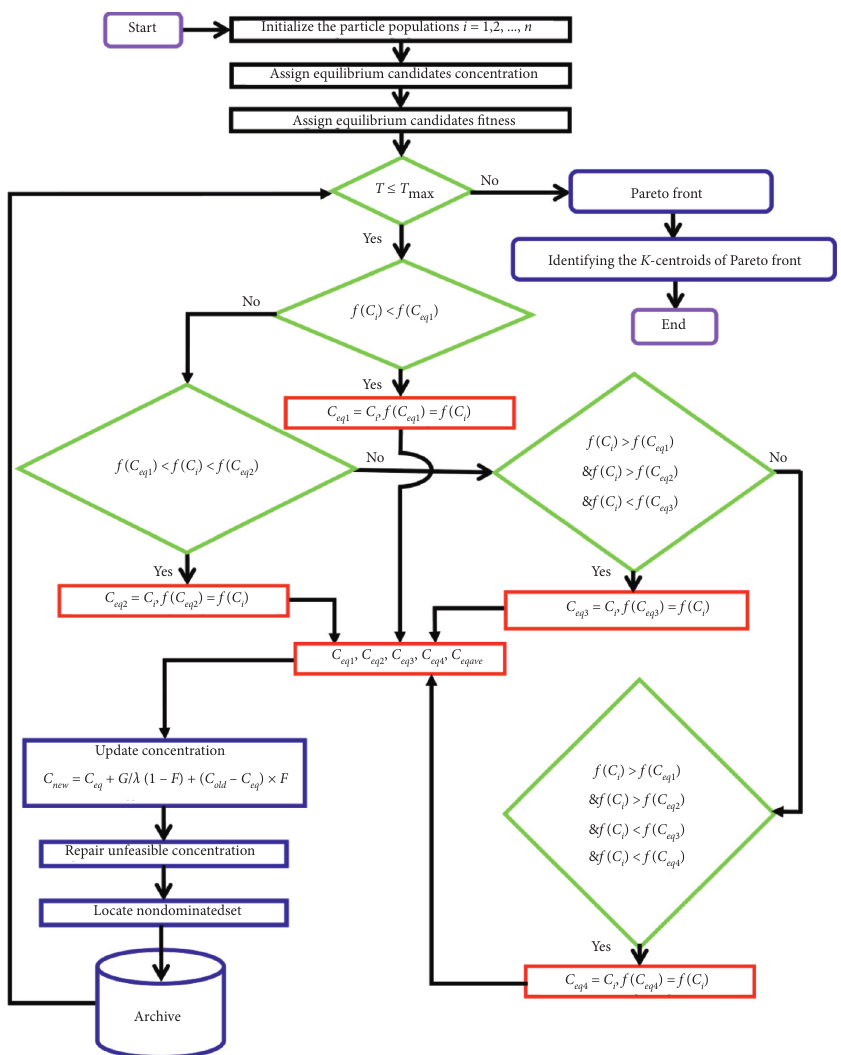
Figure 3: The structure of the proposed algorithm.